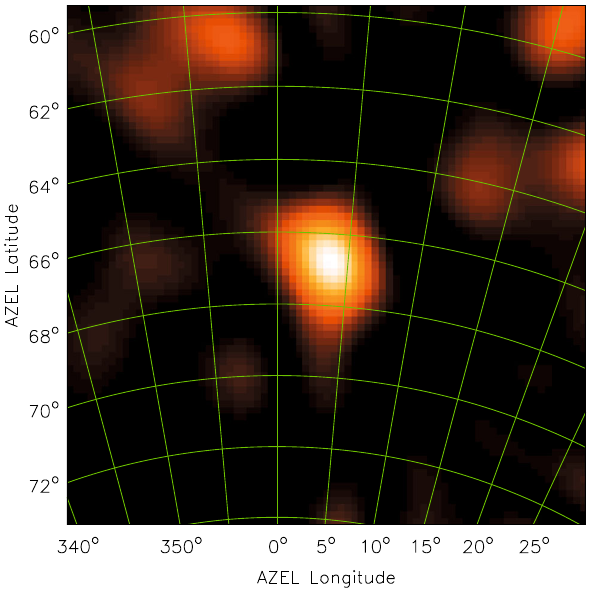
Fig. 18 Image of the radio emission of an air-shower detected by LOPES (as originally published in [6]). The bright spot in the center indicates the arrival direction of the air